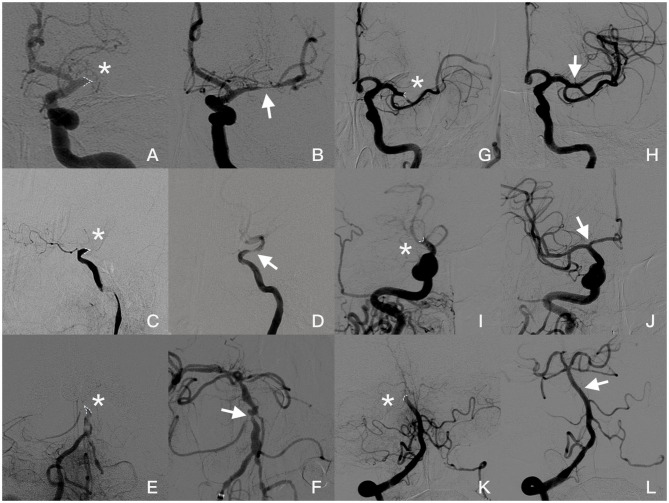
Angiogram images of a patient with jet-like appearance (A–F): (A,B) Jet-like appearance at the origin of the left MCA in late arterial phase (asterisk). Severe stenosis (arrow) was seen in the MCA after first attempted thrombectomy. (C,D) Occlusion at supraclinoid of ICA presented as a jet-like appearance (asterisk). After the small-volume thrombus was removed, severe stenosis is shown (arrow) after the ophthalmic artery was taken off and forward blood flow was significantly affected. (E,F) Basilar artery occluded at AICA take-off (asterisk). Severe stenosis was seen after two thrombectomy attempts; however, blood flow speed was normal, and no further angioplasty was required. Angiogram images of patients without jet-like appearance (G–L). (G,H): Concave appearance of the occluded left MCA (asterisk), and post-thrombectomy angiography showed recanalization of the superior branch of MCA without focal stenosis. (I,J) Occlusion at the end of ICA with concave appearance (asterisk). Both MCA and ACA were recanalized without focal stenosis (arrow). (K,L) Appearance of top of basilar artery occluded (asterisk) and recanalized (arrow) in a female with atrial fibrillation. Occlusion appearance in angiography was figured out by dotted line.